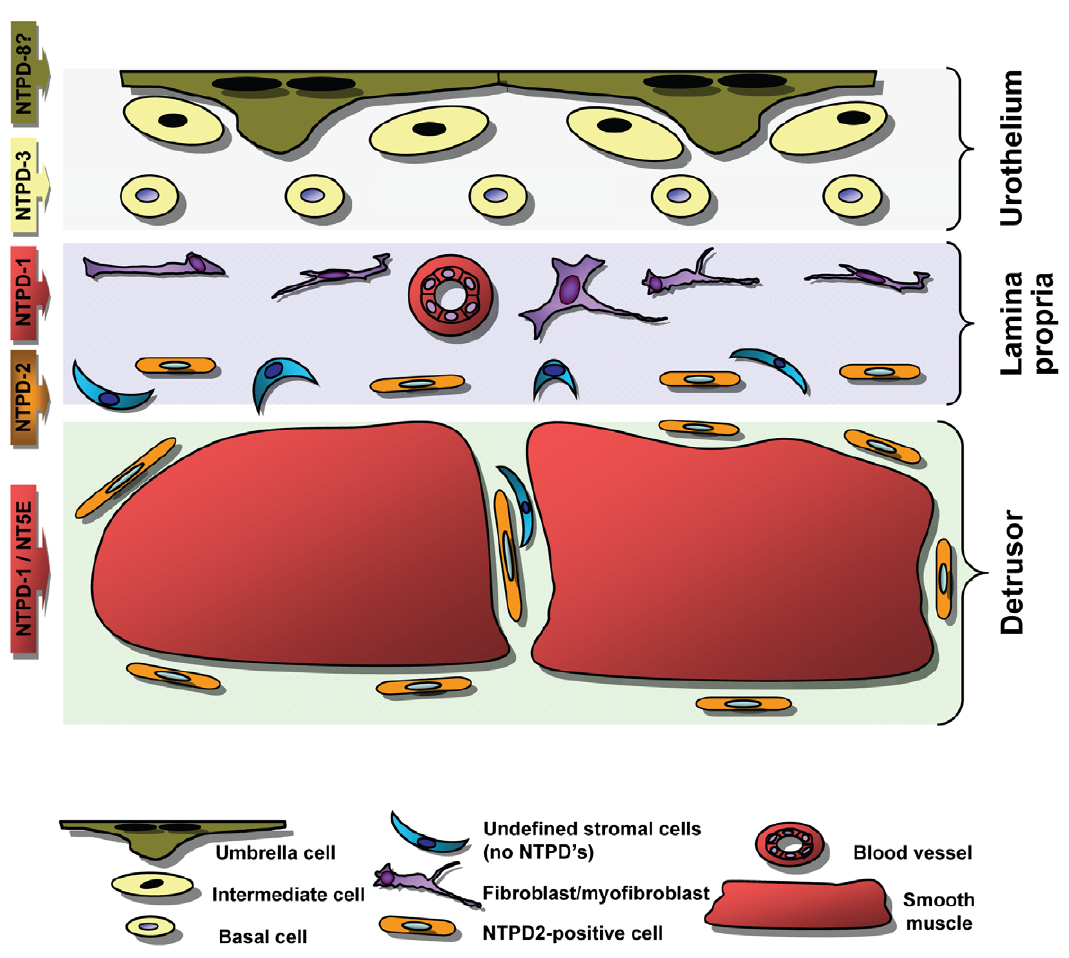
Figure 9. Model of urinary bladder showing differential distribution of nucleotidases. Three tissue layers of the bladder are shown with the cells we have identified as expressing nucleotidases. For the sake of clarity, afferent and efferent neurons have not been included. Different cell types are color coded with the banner arrows at left indicating which colored cells express which nucleotidases. Within the lamina propria, FSP1- positive fibroblasts and a -SMA-positive myofibroblasts localize to the suburothelial region (purple cells) and appear absent or rare closer to the detrusor smooth muscle. The region of the lamina propria adjacent to the smooth muscle is rich in NTPD2-positive cells. They also surround and intercalate between muscle bundles. NTPD8 is indicated in umbrella cells with a question mark to reflect a degree of uncertainty and endothelium of blood vessels are labeled with NTPD1.